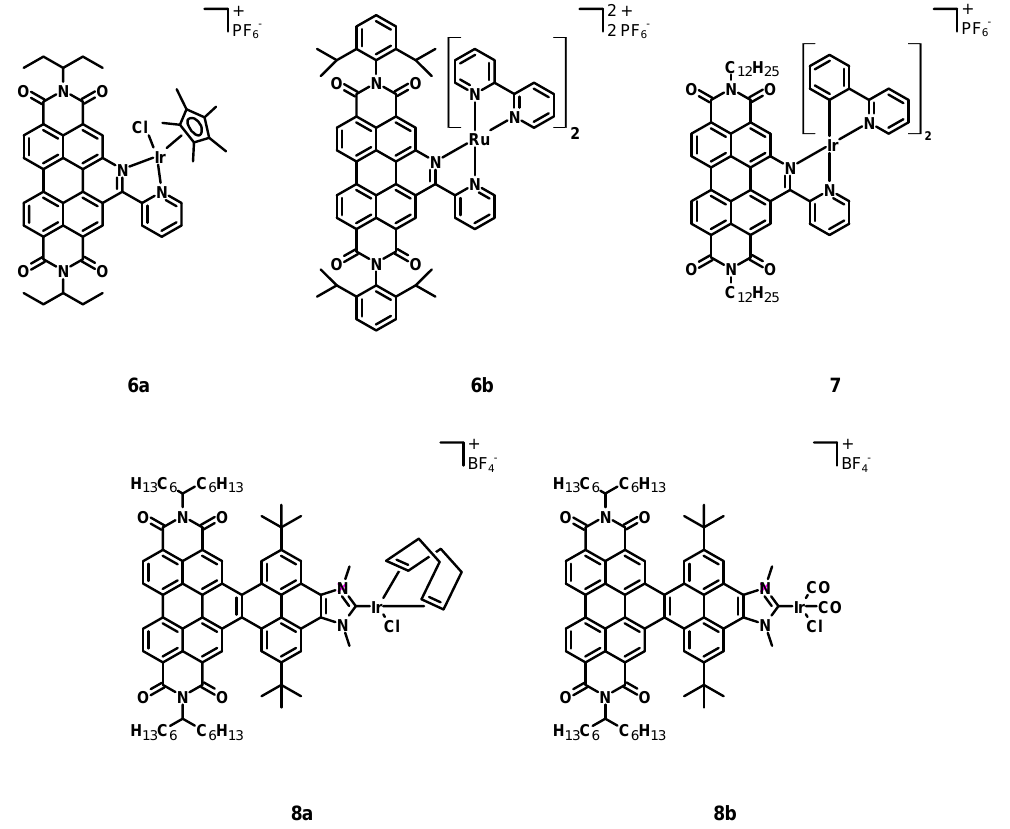
Figure 4. Structures of complexes 6a – b , 7 , and 8a – b .